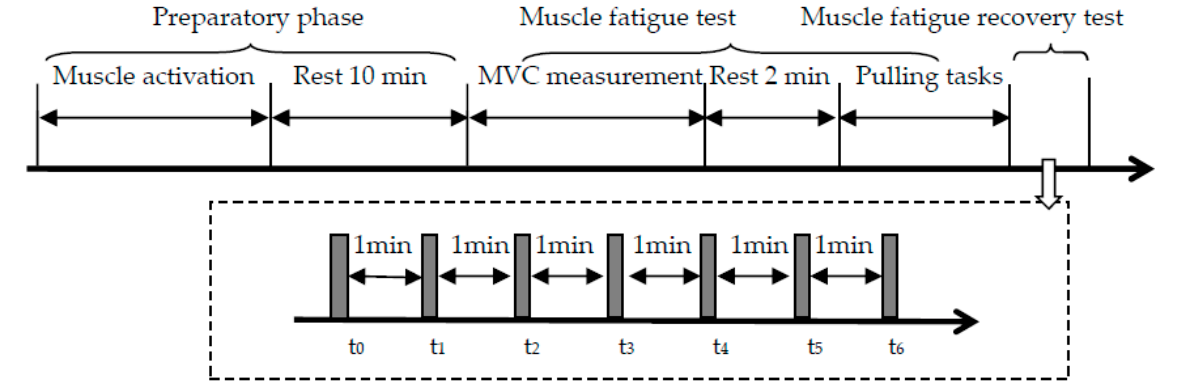
Figure 3. Experiment procedure.